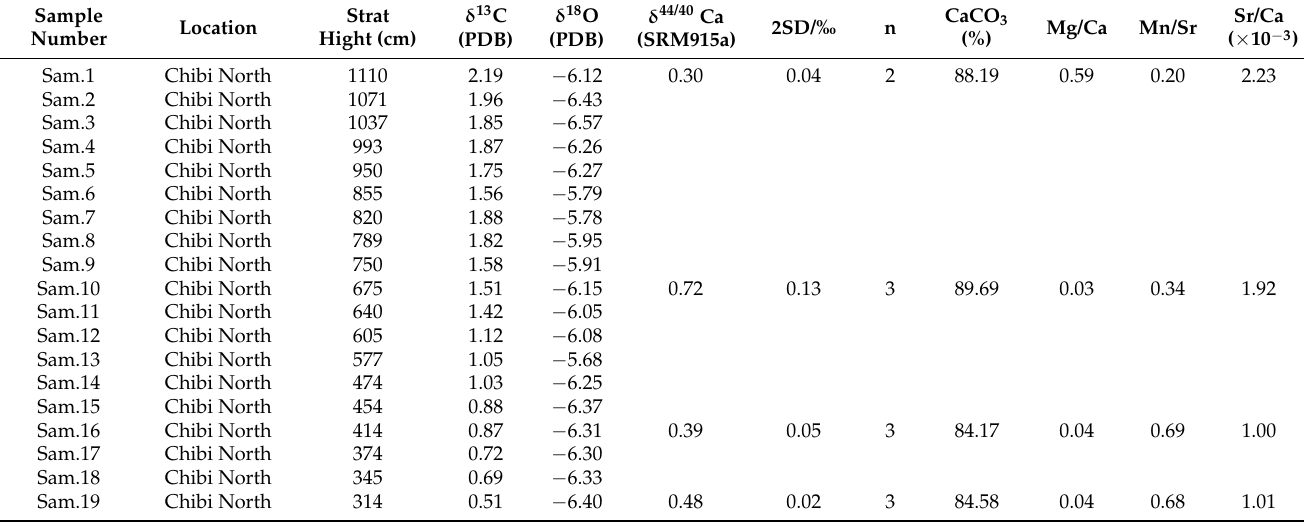
Table 1. Element and isotope composition of the studied carbonate